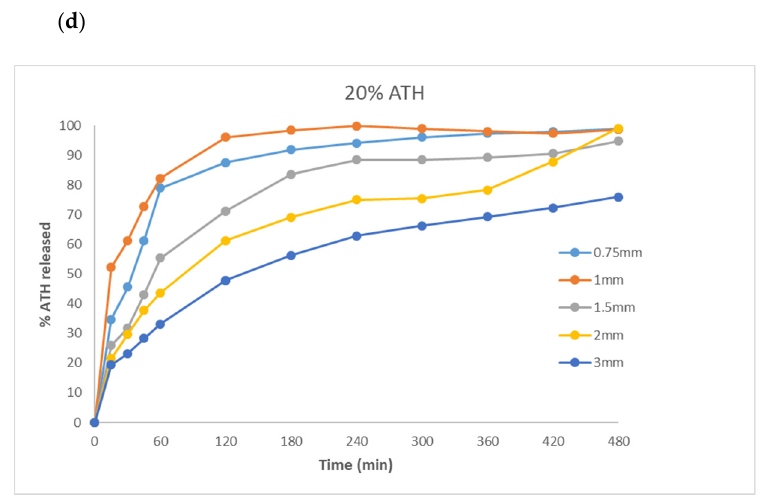
Figure 4. Dissolution profiles of fabricated tablets containing: ( a ) 5%; ( b ) 10%; ( c ) 15%; and ( d ) 20% of ATH.